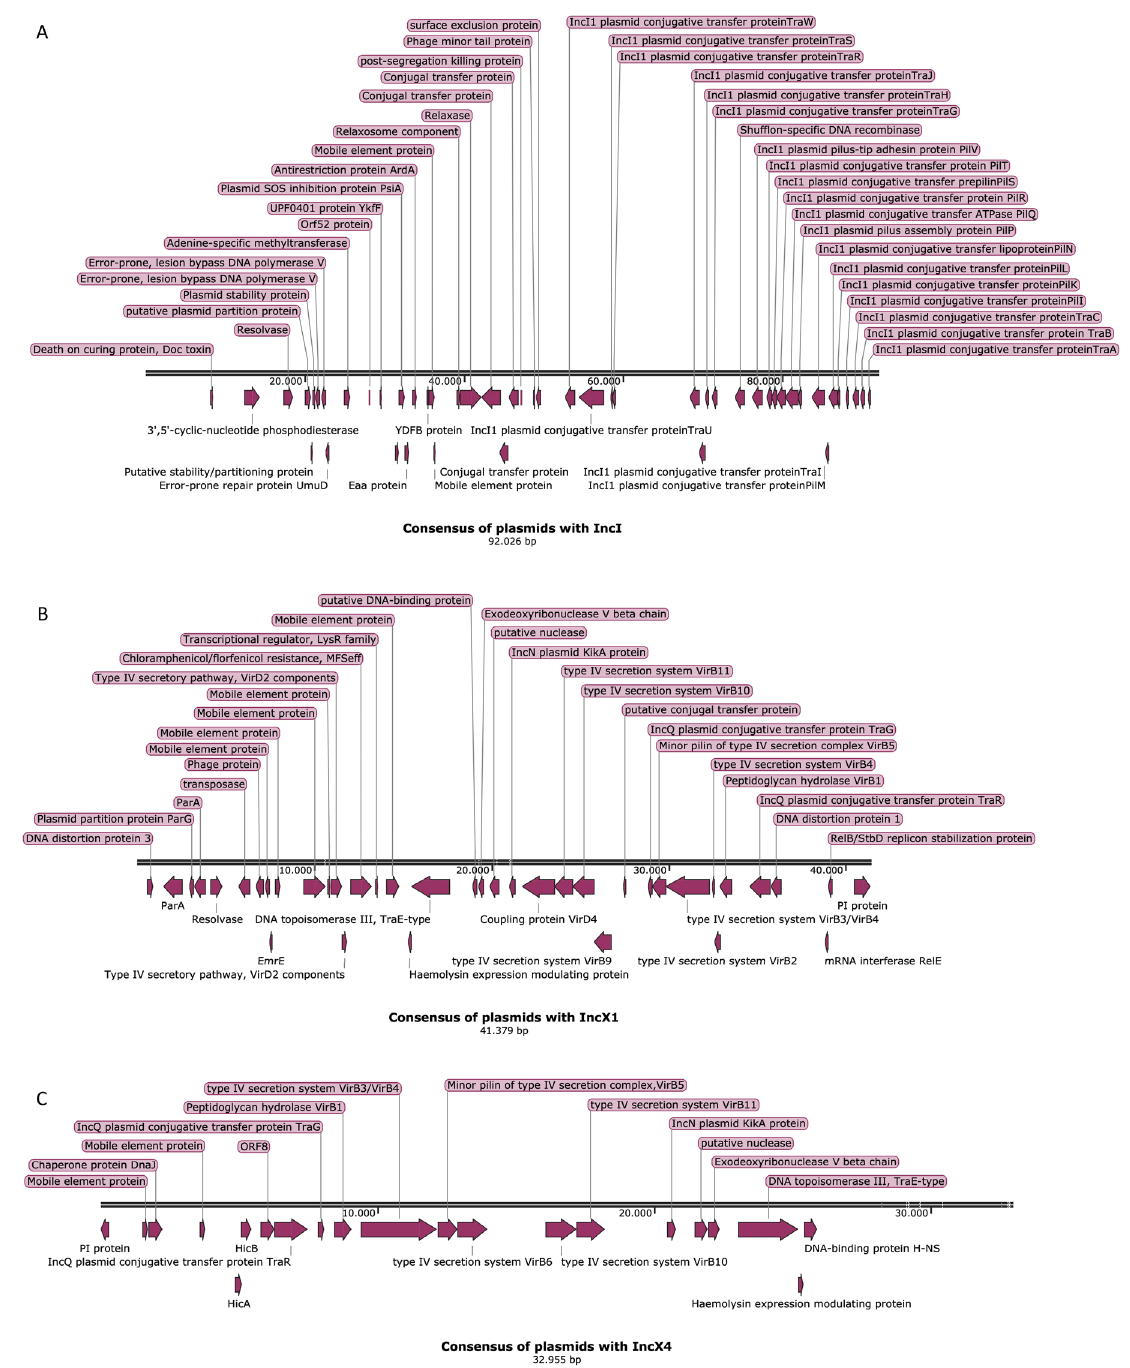
Figure 4. Annotated consensus sequences of the IncI ( A ), IncX1 ( B ) and IncX4 ( C ) type